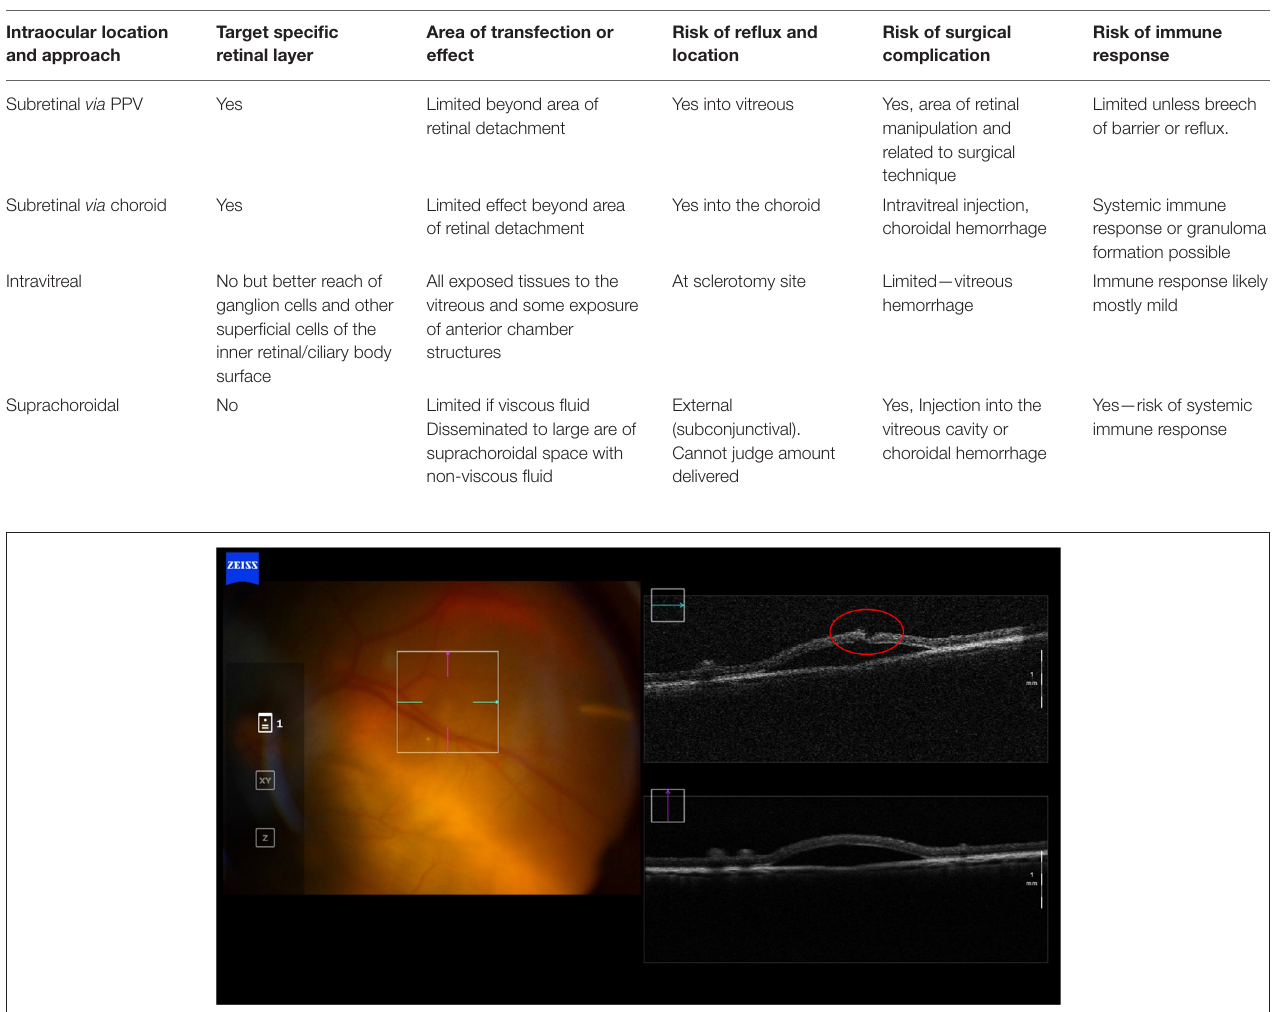
TABLE 1 | Advantages and drawbacks of surgical approaches for retinal delivery.